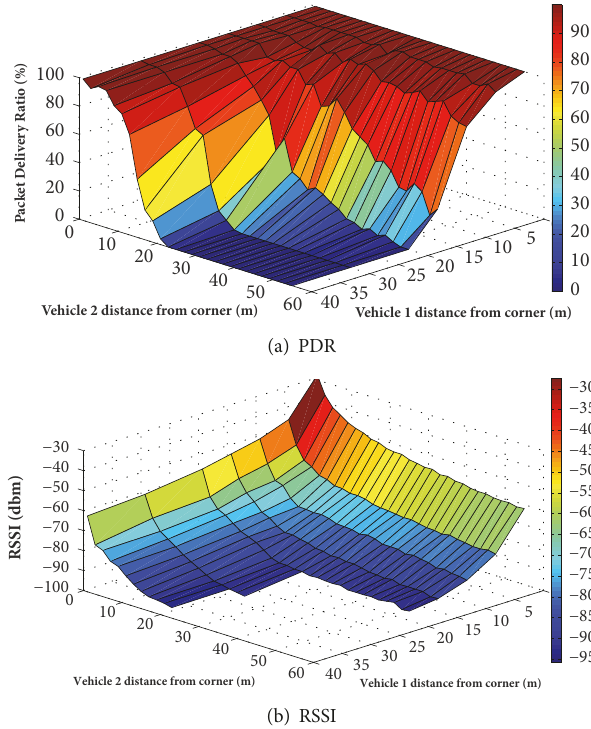
Figure 15: Results from the simulation with 𝛼 = 1.3 for blind corner with large obstruction. (a) PDR. (b)